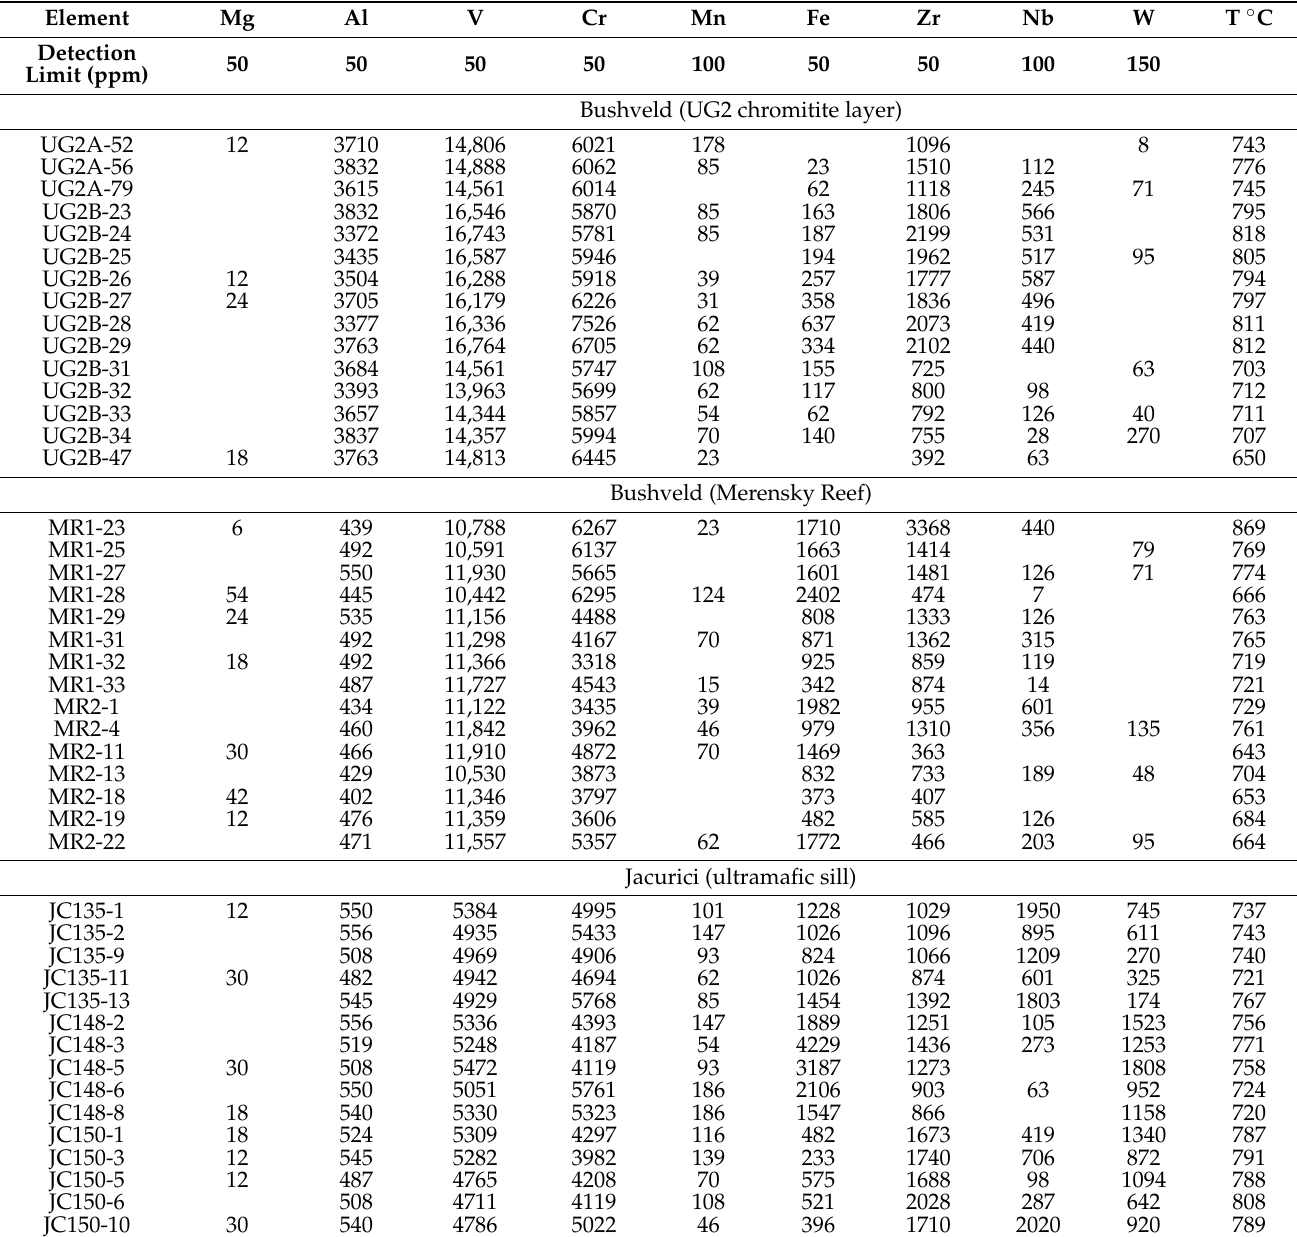
Table 3. Trace elements concentration (ppm) and Zr-based crystallization temperature for selected rutile grains in chromitites.